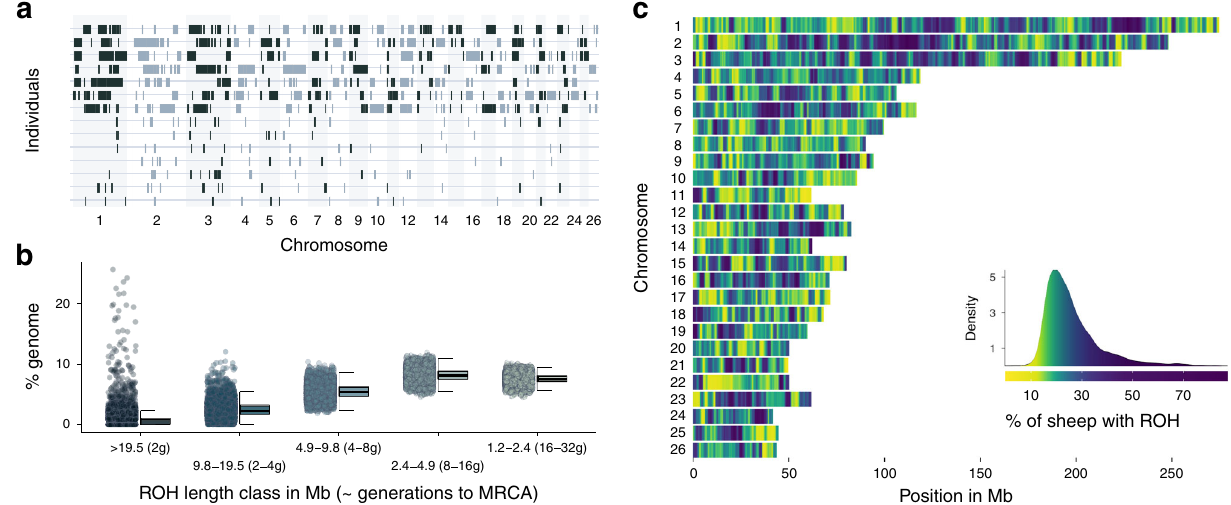
Fig. 1 Runs of homozygosity (ROH) variation among individuals and across the genome. a ROH longer than 5 Mb in the seven individuals with the highest inbreeding coef fi cients F ROH in the seven top rows and the seven individuals with the lowest F ROH in the seven bottom rows. b Distribution of ROH among different length classes. Each data point represents the proportion of ROH of a certain length class within an individual ’ s autosomal genome. ROH length classes were categorised by their expected average physical length when the underlying haplotypes had a most recent common ancestor (MRCA) 2 – 32 generations ( g ) ago. c Genome-wide ROH density among all 5952 individuals in non-overlapping 500 Kb windows. The colour gradient has been scaled according to the ROH density, which is shown in the fi gure a mean minor allele frequency (MAF) of 23% (Supplementary Fig. 2) and a mean call rate of 99.5% across individuals.